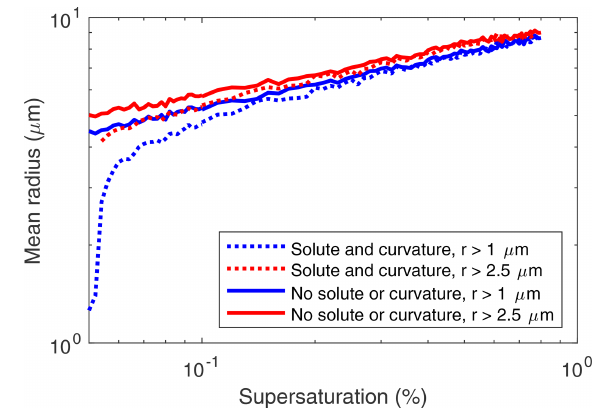
Figure 7. Average over the 11 DSDs of the coefficient of variation of the nominal mean supersaturation values implied by the three measured moments versus the truncation radius.